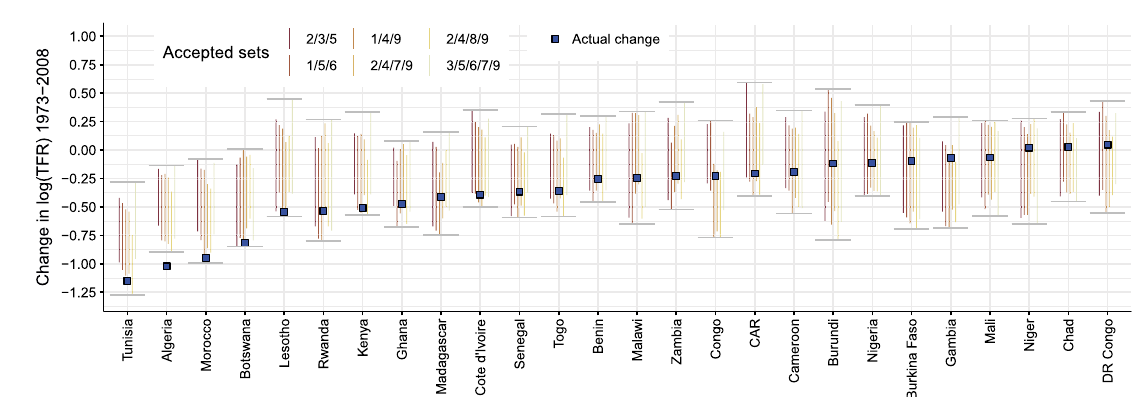
Figure 4: The confidence intervals show the predicted change in log ( TFR ) from 1973–2008 for all African countries when not using their data in the nonlinear ICP estimation (using invariant conditional quantile prediction with α = 0 . 1). In other words, only the data from the remaining five continents was used during training. The horizontal line segments mark the union over the accepted models’ intervals for the predicted change; the blue squares show the true change in log ( TFR ) from 1973–2008. Only those countries are displayed for which the response was not missing in the data, i.e. where log ( TFR ) in 1973 and in 2008 were recorded. The coverage is 25 / 26 ≈ 0 .